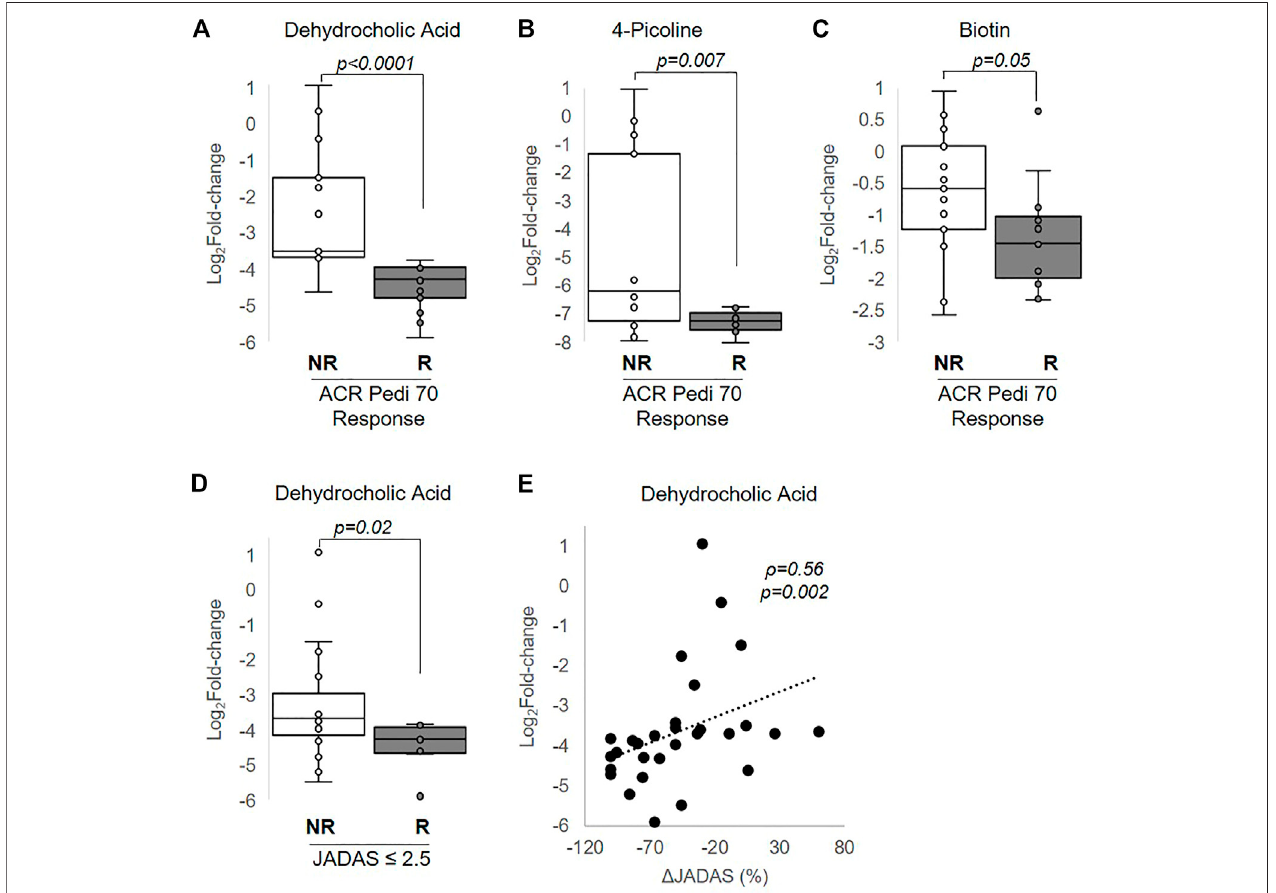
FIGURE5| Association ofchangesinmetabolite levels with MTX ef fi cacy at 3months.The fold-changein (A) dehydrocholic acid, (B) 4-picoline, and (C) biotin are compared between responders and non-responders based on achievement of ACR Pedi 70 response criteria. (D) The fold-change in dehydrocholic acid over the 3- months treatment period is compared between responders and non-responders based on achievement of a JADAS ≤ 2.5. (E) The association between fold-change in dehydrocholic acid and percentage change in JADAS-71 was evaluated by Spearman ’ s rank correlation analysis. The resulting Spearman ’ s correlation coef fi cient ( ρ ) and associated p-values are provided. Unpaired analysis in (A – D) were conducted by Wilcoxon rank-sum analysis and the resulting p-values are provided.